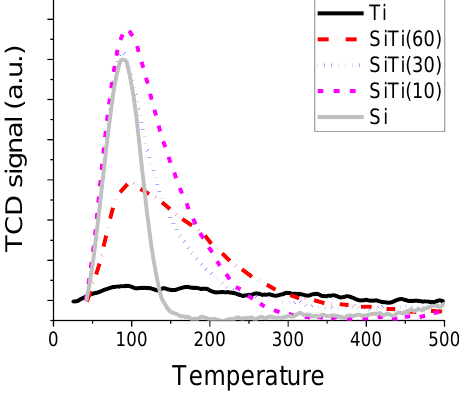
Figure 4. TPD profiles for ammonia desorption for silica and/or titania containing supports.